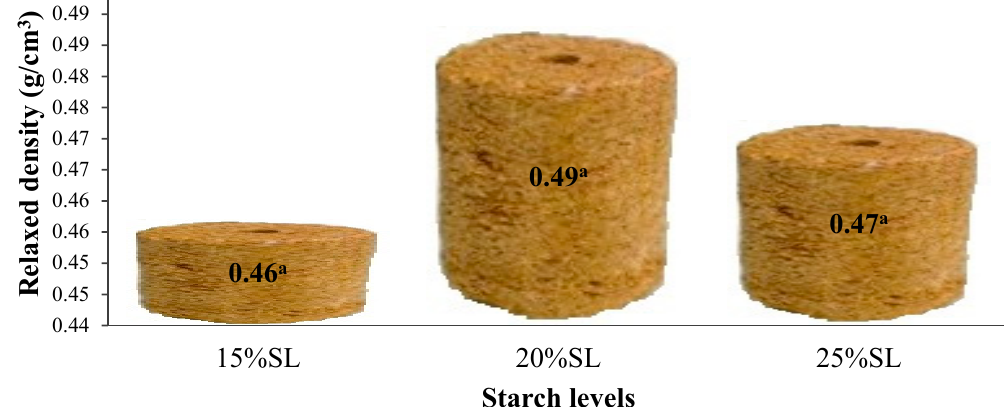
Figure 5. Mean effect of treatments on density (g/cm 3 ) of briquette. Means in the same bar having the same superscript are not significantly different ( p ≥ 0.05).